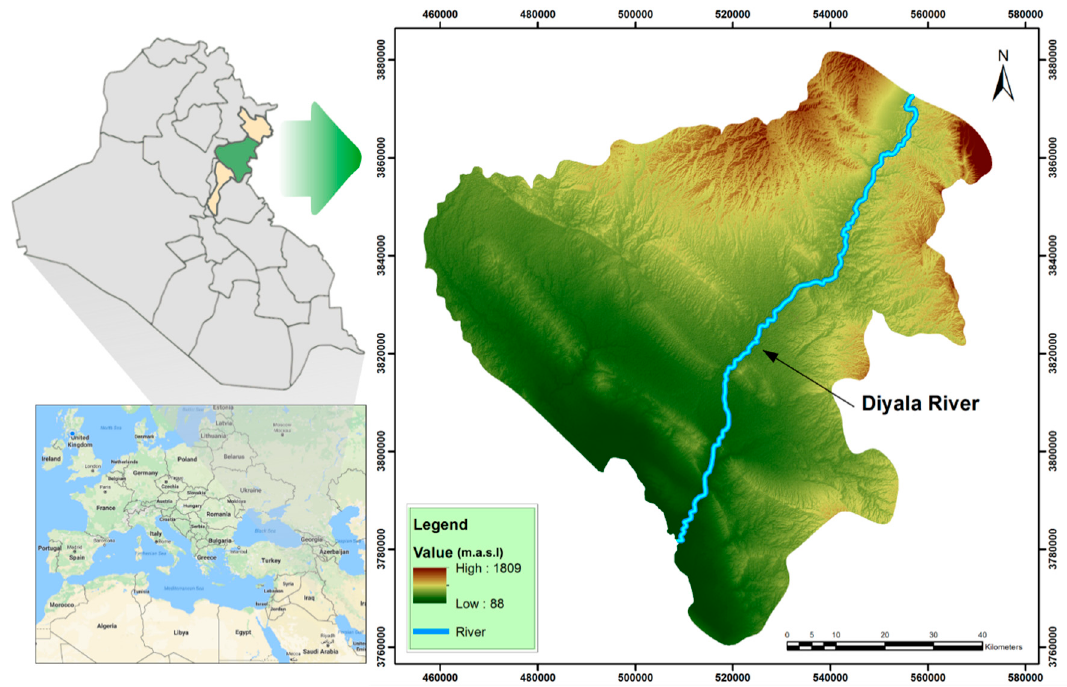
Figure 1. Location and topography of Diyala River Basin in Iraq (UTM coordinate system).